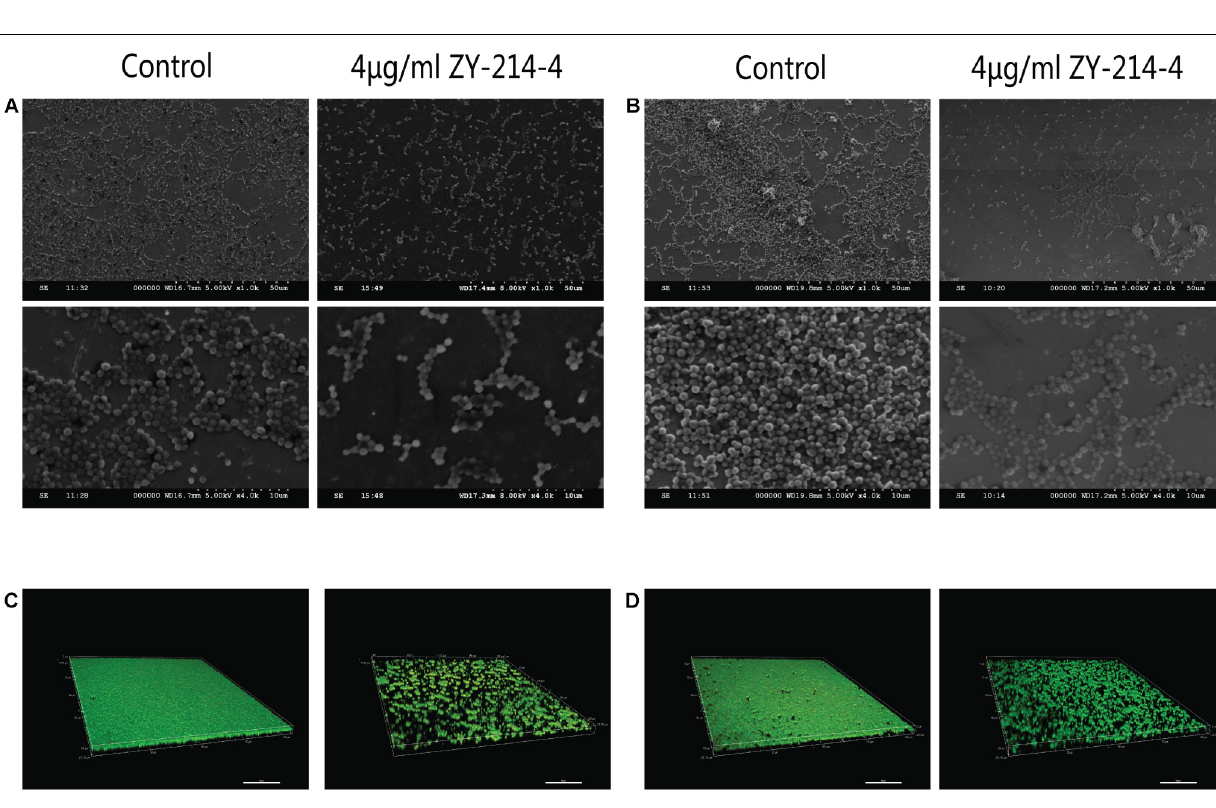
FIGURE 4 | Effect of ZY-214-4 on S. aureus biofilm formation evaluated by microscopy. (A–D) The antibiofilm potential of ZY-214-4 against S. aureus clinical isolates SA21 (A,C) and SA923 (B,D) was visualized by SEM (A,B) and CLSM (C,D) .